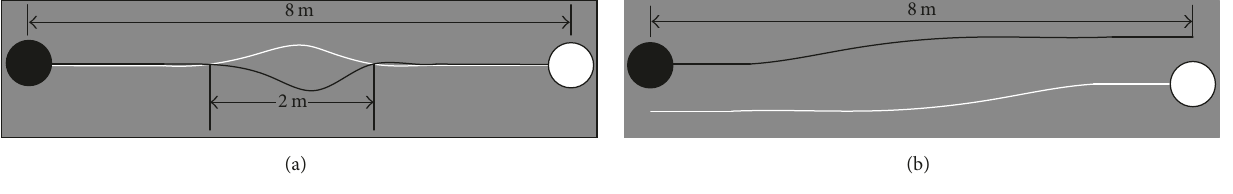
𝜆 = 0.1 m, the number of lanes is 6. As shown in Figure 13(d), when 𝜆 = 0.4 m, the number of lanes is 2. The results indicate that, with the increase of 𝜆 , the number of lanes